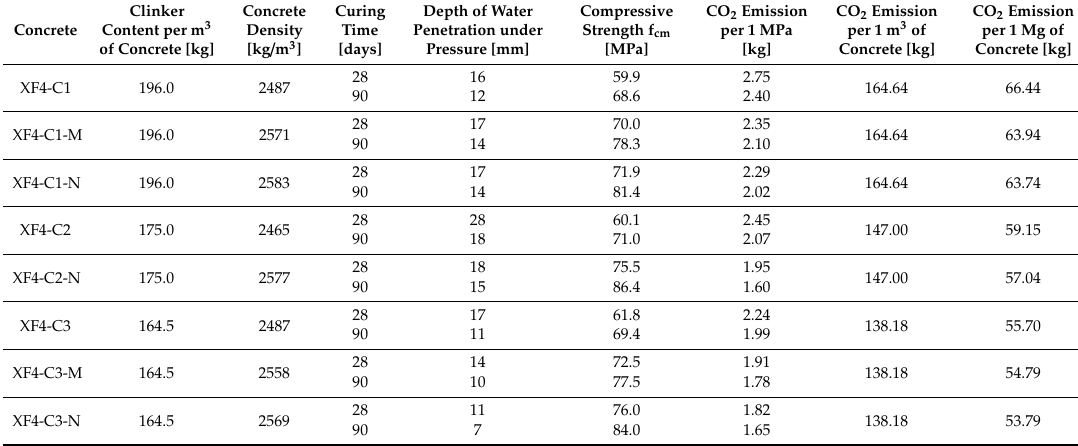
Table 9. Properties of XF4 concretes with CO 2 emission level.